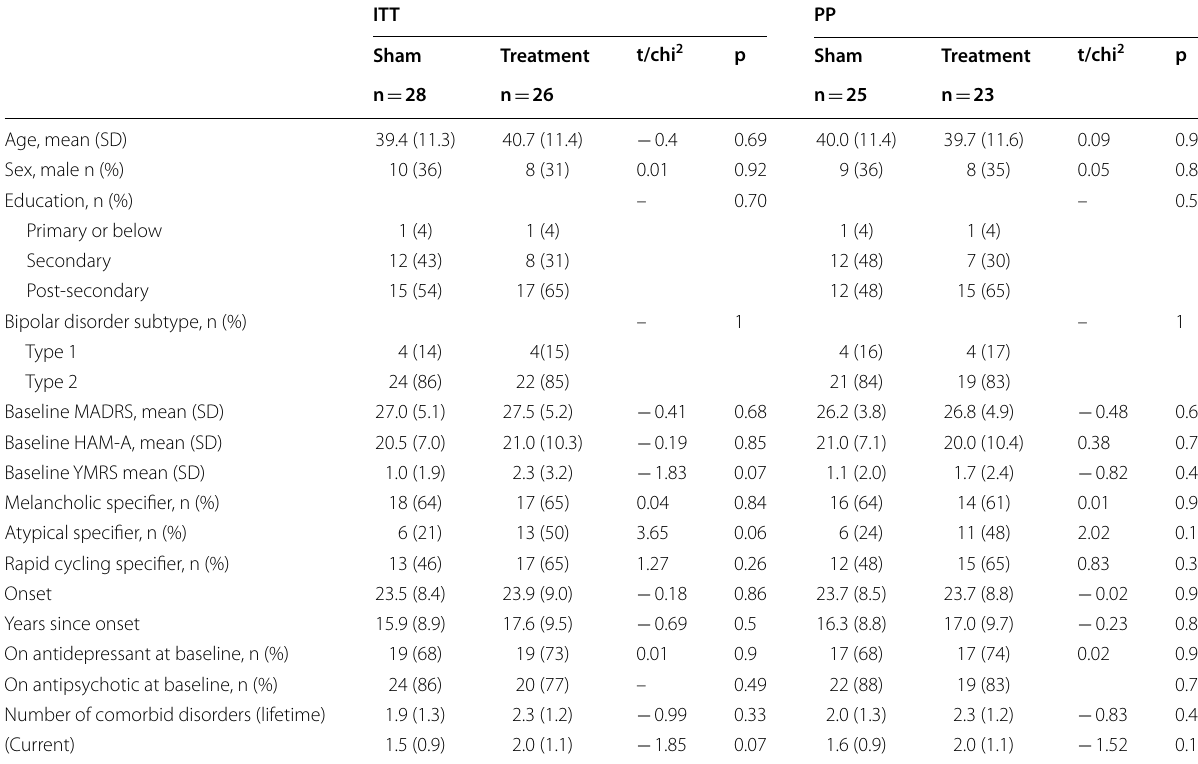
Table 1 Demographic and clinical